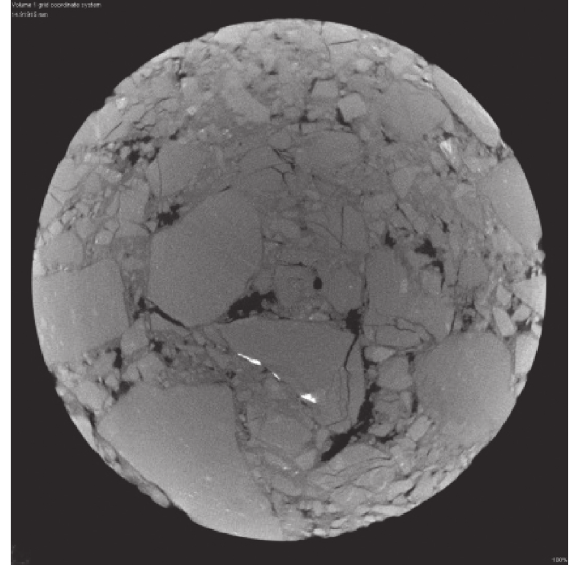
Figure 3: CT scanning image of CSM